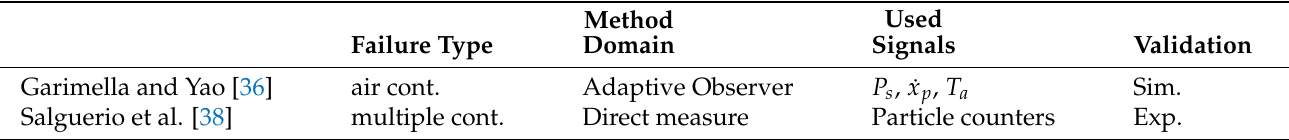
Table 5. Covered fault detection methods for fluid failures. The notations of the used signals can be found in Figure